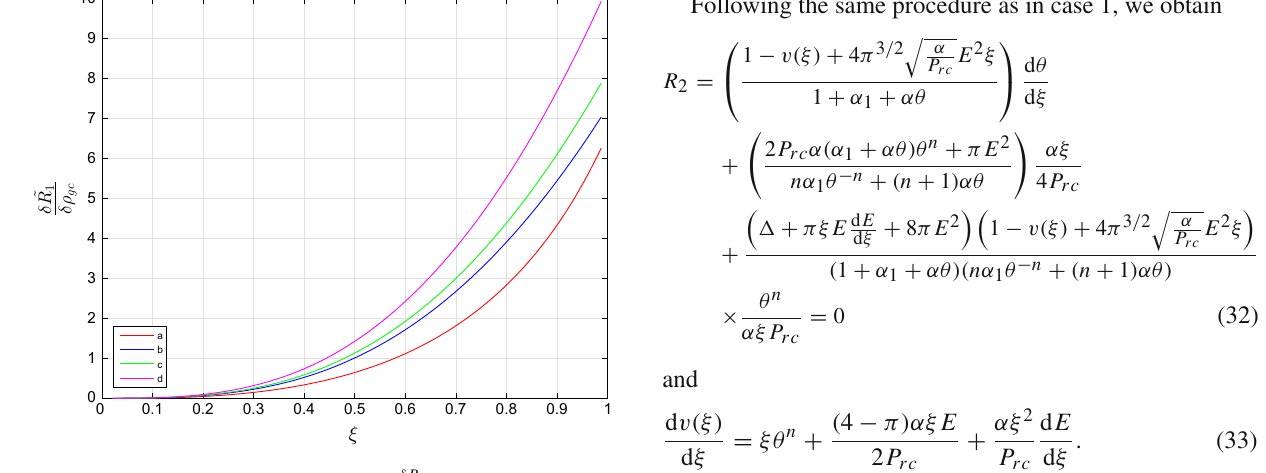
Fig. 1 Case 1: Perturbation through LDP. δ R 1 δρ n = 1 , α = 8 × 10 − 11 , α 1 = 0 . 2, Red curve ρ gc = 10 7 , q = 0 . 2 M (cid:7) , blue curve ρ gc = 10 7 , q = 0 . 4 M (cid:7) , green curve ρ gc = 10 11 , q = 0 . 2 M (cid:7) , magenta curve ρ gc = 10 11 , q = 0 . 4 M